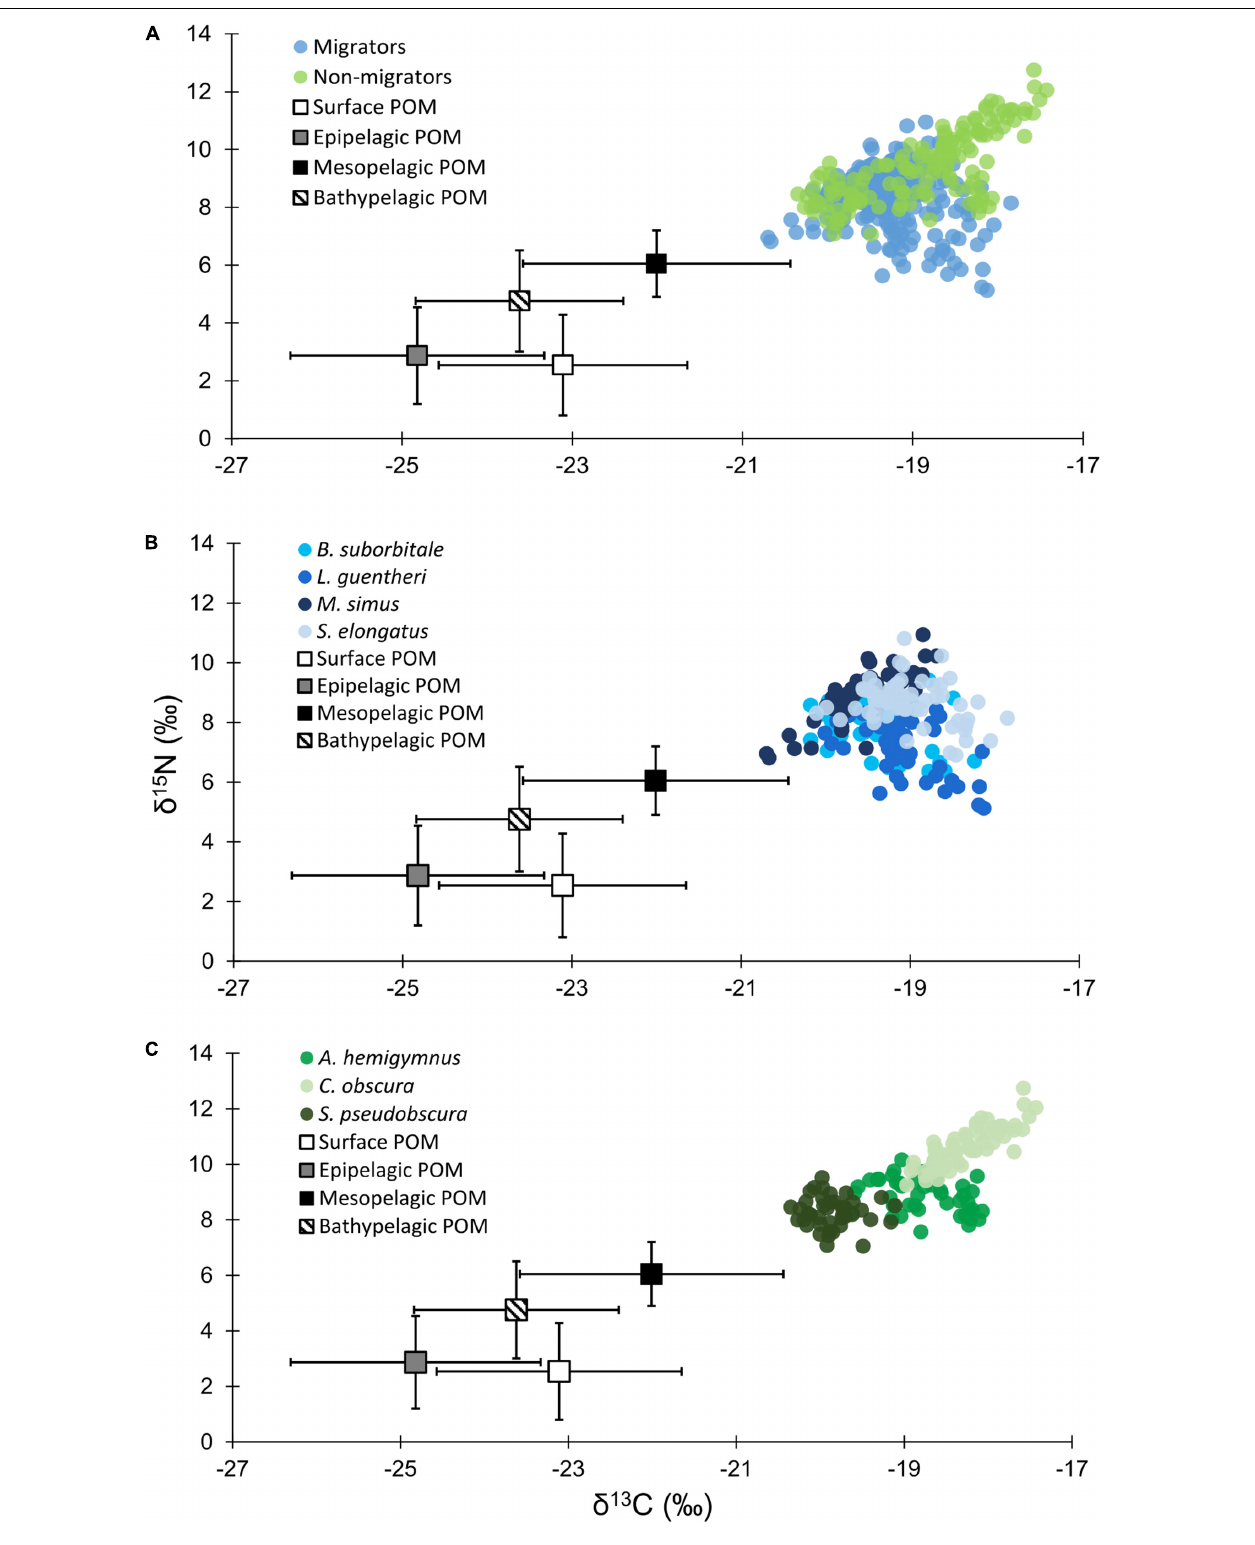
FIGURE 3 | (A) Isotope biplot displaying mean ( ± SD) δ 13 C and δ 15 N values for particulate organic matter from each depth zone (squares) and individual δ 13 C and δ 15 N values for all vertically migrating (blue circles) and non-migrating (green circles) fish species. (B) Individual δ 13 C and δ 15 N values of vertically migrating species. (C) Individual δ 13 C and δ 15 N values of non-migrating